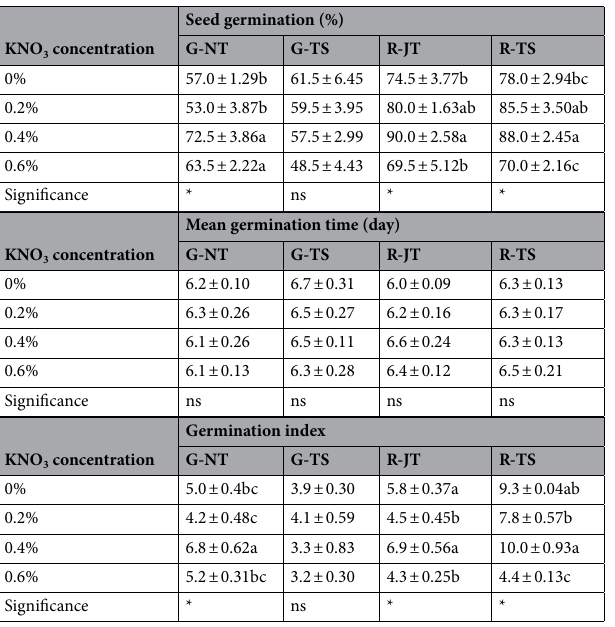
Table 2. Final seed germination percentage (GP) and mean emergence time (MGT) and germination index (GI) at 15 days after sowing of four holy basils as affected by seed priming with KNO 3 , on top of the filter paper with white LED. Data are mean values ± SE (n = 4) with four fifty seeds in a replication. Different letters in the same column indicate significant difference at p < 0.05. * indicates significant difference. “ns” indicates no significant